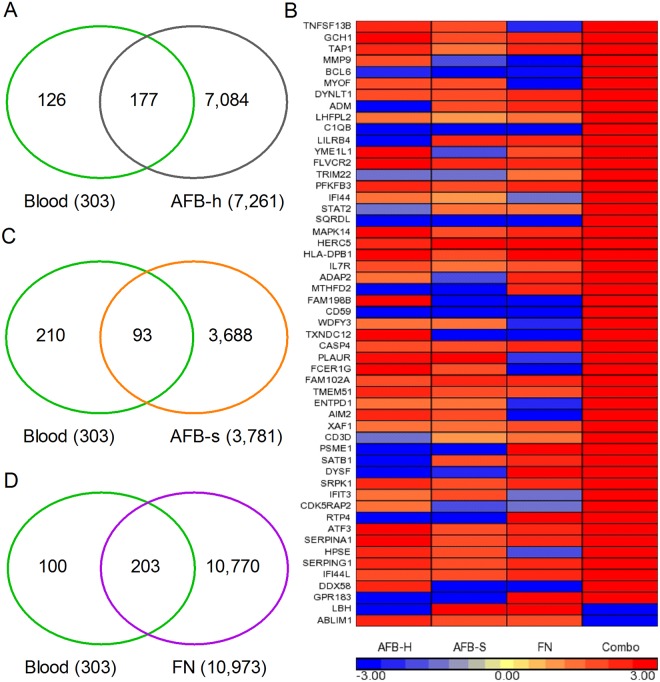
Expression of blood biomarkers of active TB in different TB granulomas.(A). Venn diagram showing comparison of blood TB biomarker profile (green circle) to SDEG from cavitary lung lesion with high AFB (AFB-h; grey circle). (B). Intensity plot of blood TB biomarker genes expressed in cavitary granulomas with scanty (AFB-s) or high (AFB-h) bacillary load, fibrotic nodule (FN) or common to all lesions versus pooled lung transcriptome (Combo). The up-regulated SDEG are in red and down-regulated SDEG are in blue and the intensity of the color is proportional to their expression level (i.e., stronger expression is represented as dark shades). Expression pattern in Combo is sorted in descending order (top to bottom). Scale bar ranges from +3 (red) to -3(blue). (C). Venn diagram showing comparison of blood TB biomarker profile (green circle) to SDEG from cavitary granuloma containing scarce bacillary load (AFB-s; orange circle) in the TB lungs. (D). Venn diagram showing comparison of blood TB biomarker profile (green circle) to SDEG from fibrotic nodule (FN; purple circle) in the TB lungs. For A, C and D, numbers in parenthesis indicate total number of SDEG.